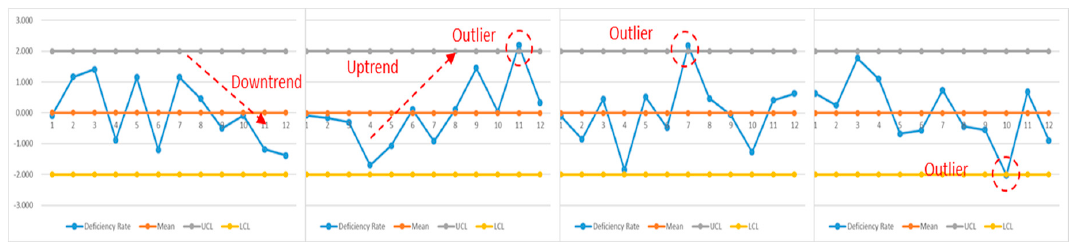
Figure 11. The control chart for deficiency 06 (2015–2018).